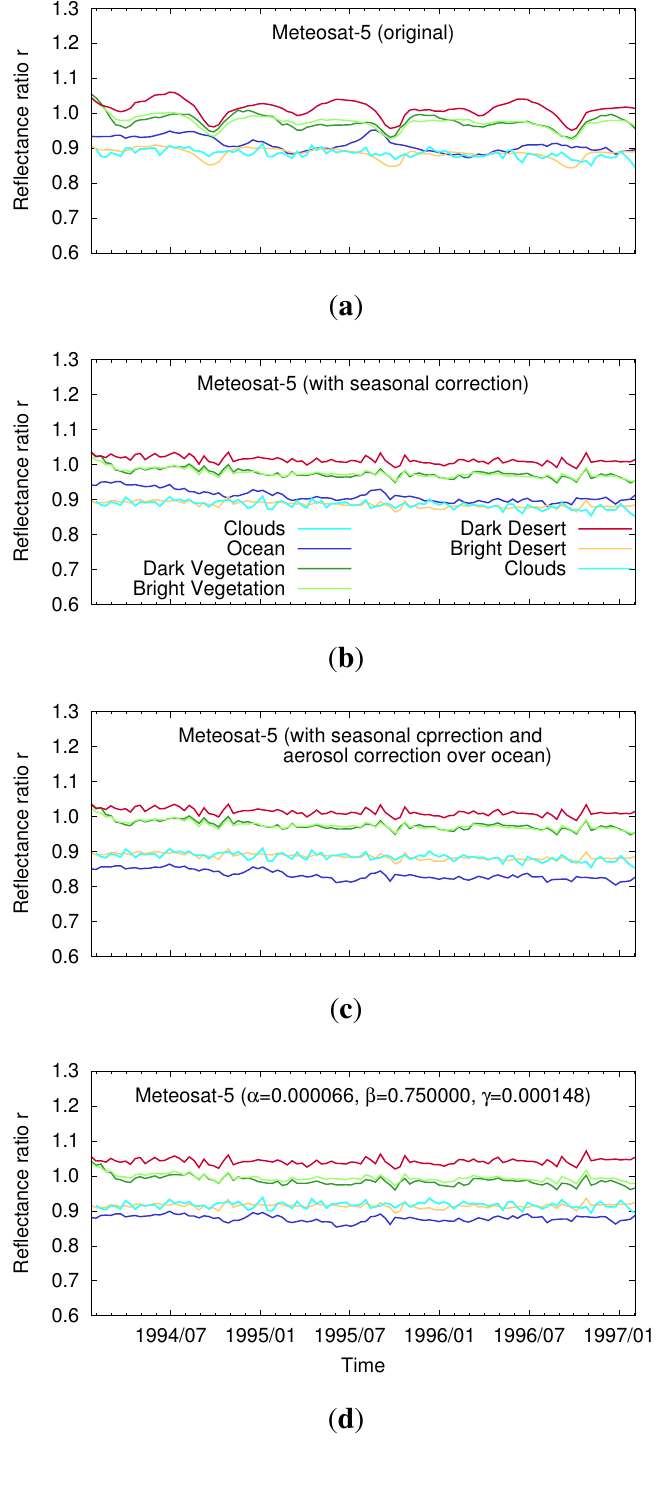
Figure 12. Meteosat-5 time series ( a ) original; ( b ) after seasonal correction; ( c ) after aerosol correction; and ( d ) after ageing